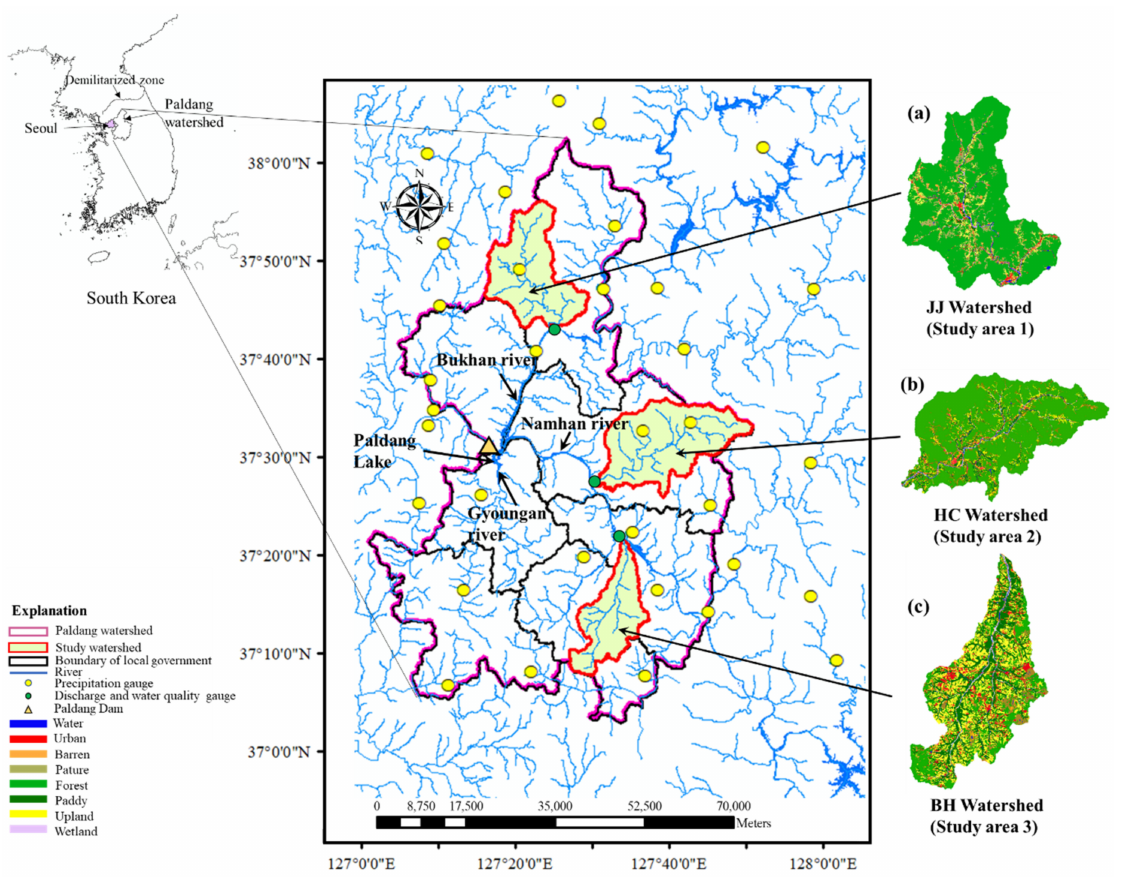
Figure 1. Location and land cover in the three study areas: ( a ) JJ watershed; ( b ) HC watershed; ( c ) BH